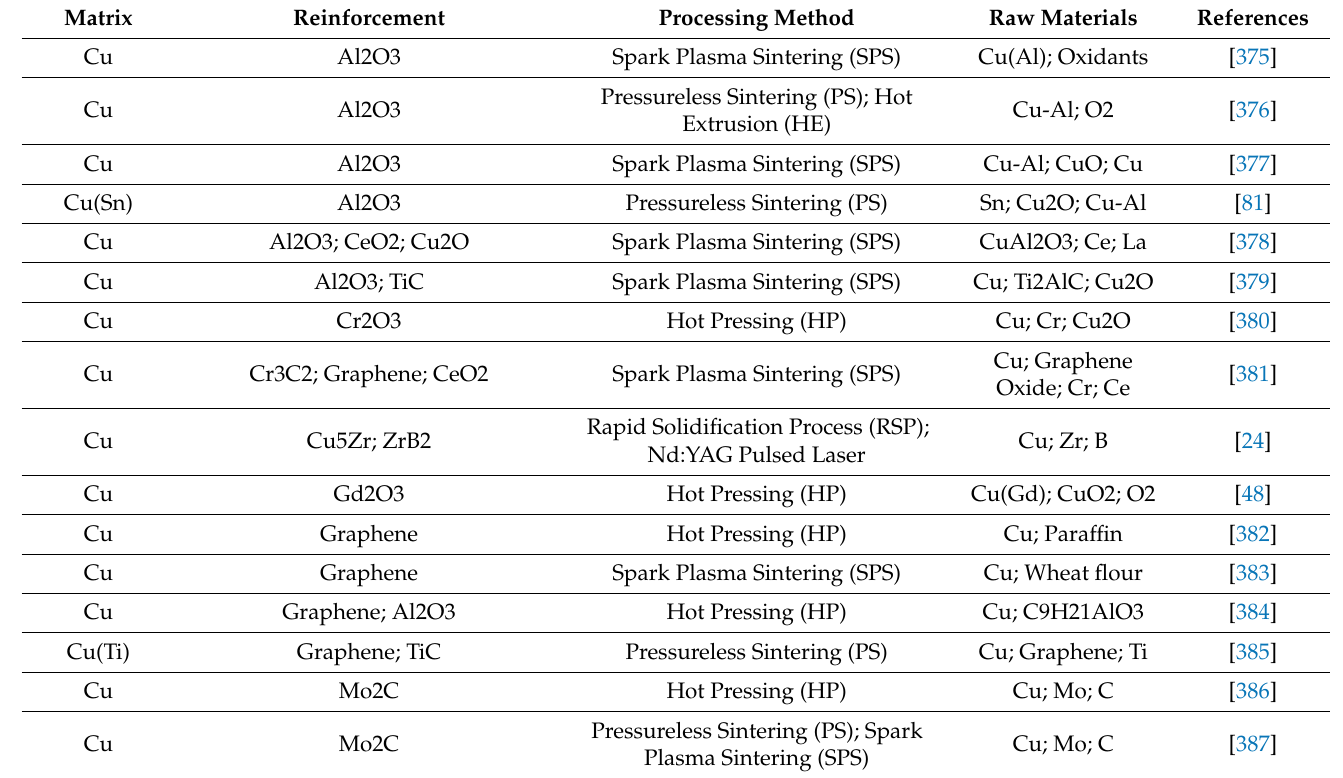
Table A5. Copper Matrix